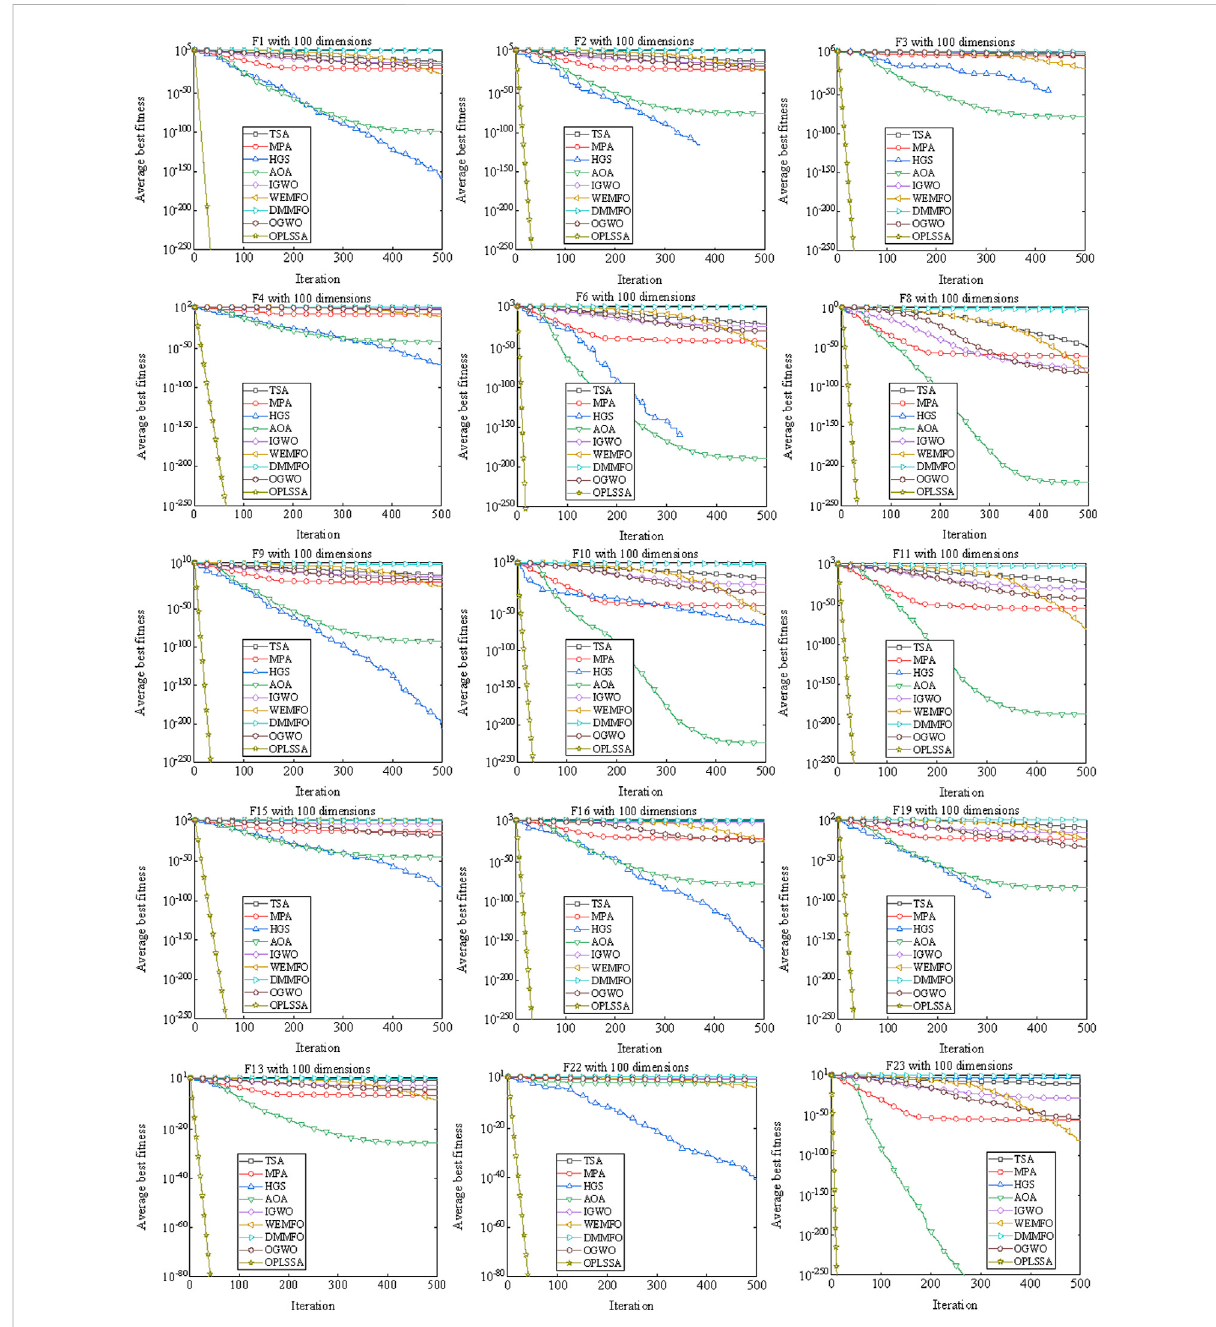
FIGURE 8 Convergence curves of OPLSSA and other Frontier algorithms on 15 representative